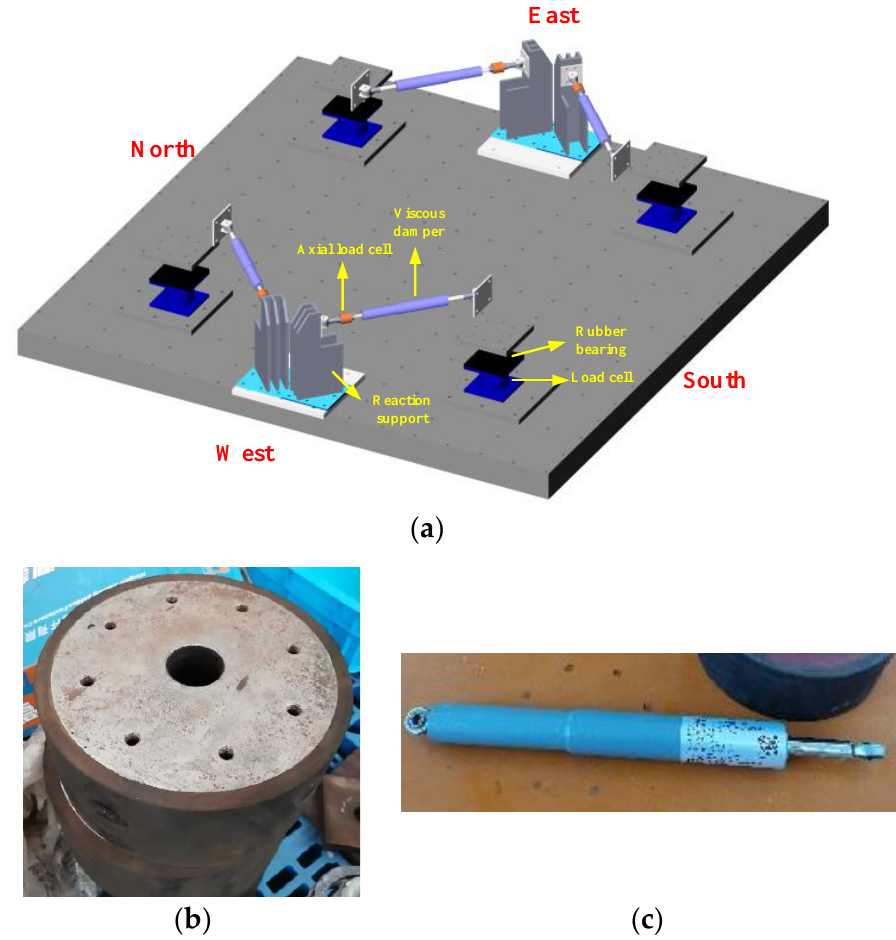
Figure 2. Base isolation system: ( a ) Layout of base isolation system; ( b ) LNR; ( c ) NLVD. Table 2. Mechanical properties of the LNRs.